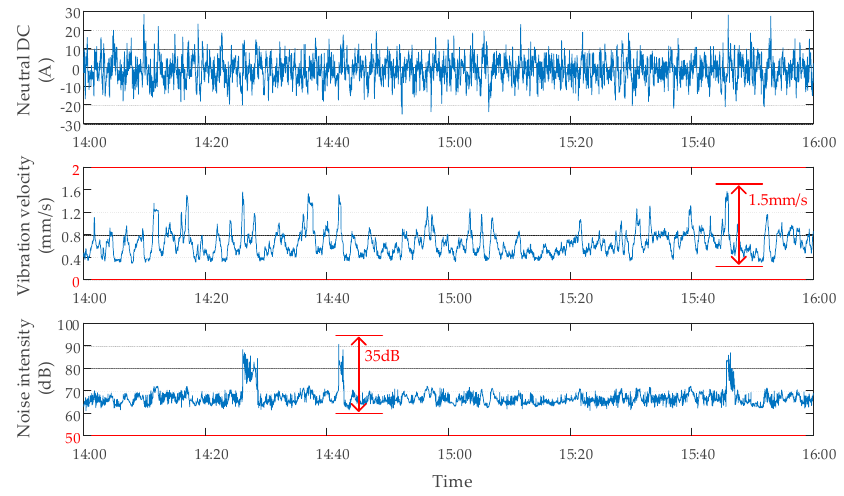
Figure 7. The data characteristics of a transformer with DC bias and suppression device off. 2.2.4. Data Characteristics When the DC Bias Occurs and the Suppression Device Is on To obtain the data characteristics when the DC bias occurs and the suppression device is on, the tests were carried out. During the operation of the subway from 14:00 to 16:00, DC bias of the transformer occurred, and the suppression device was on. The monitoring data of neutral point DC, vibration, and noise of a transformer are shown in Figure 8. The data characteristics are like those without DC bias. In addition, considering the particularity of the autotransformer, the DC bias of the autotransformer cannot be effectively suppressed by adding a single suppression device [28]. In this